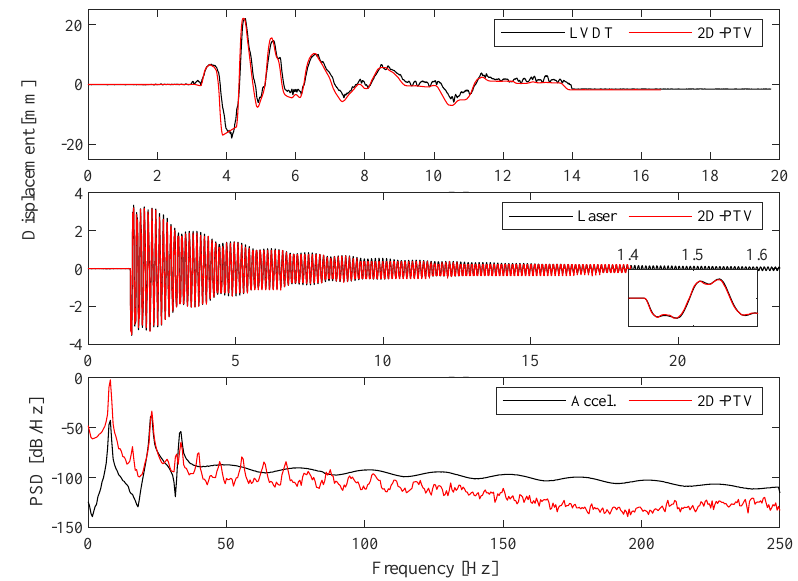
Figure 6. ( Top ) Displacement validation of 2D-PTV against LVDT for Northridge input at shake-table base. ( Middle ) Displacement validation of 2D-PTV against laser distometer for a hammer impact excitation at the top of the frame. ( Bottom ) Power spectral density validation of 2D-PTV against an accelerometer for a hammer impact excitation at the top of the frame.